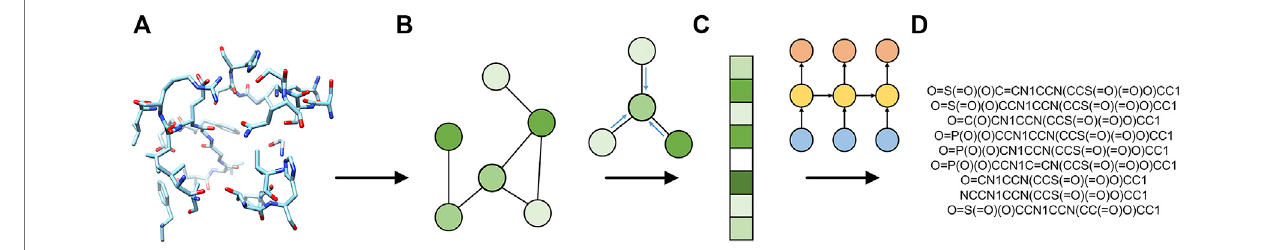
FIGURE 1 | Flowchart of Pocket2Drug. The inputligand-binding pocket (A) is fi rst represented as a graph (B) and then used by the encoder graph neural network to generate a fi xed-size graph embedding (C) . The decoder recurrent neural network generates molecule strings (D) from the graph embedding.